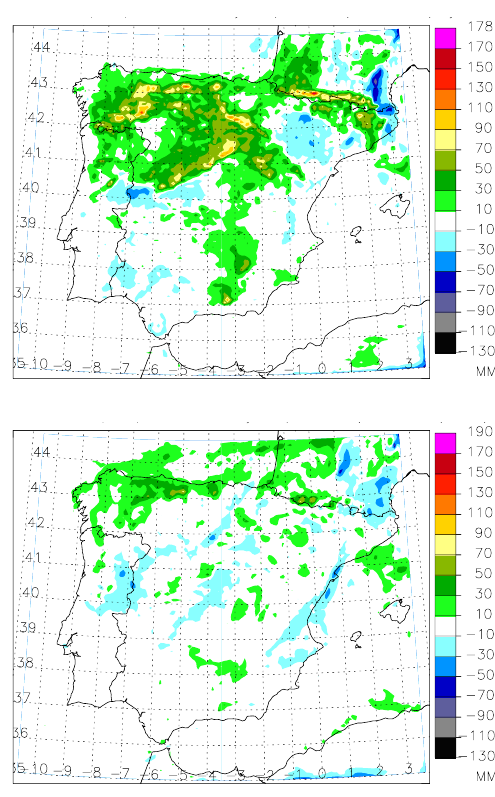
Fig. 5. Accumulated precipitation difference, in mm, from 30 May to 20 June 2002: daytime (upper panel) and nighttime (lower panel).